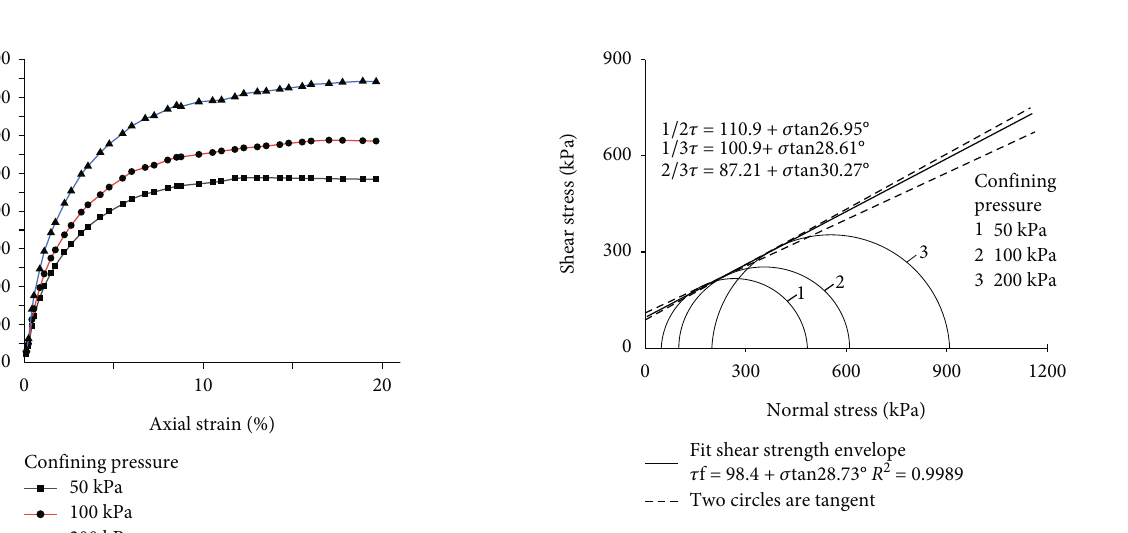
Figure 7: Mohr ’ s stress circles for triaxial tests of plain soil samples.